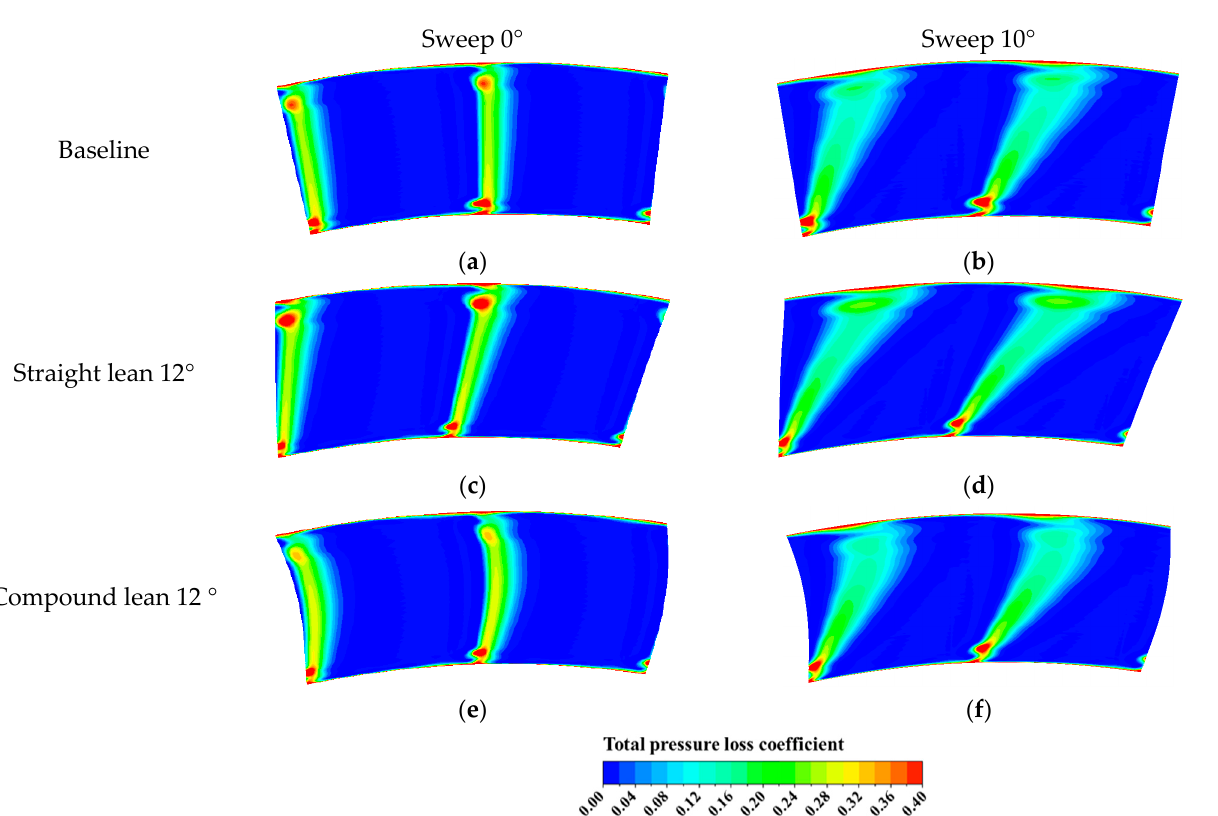
Figure 10. Distributions of total pressure loss coefficient at NGV exit, z/C ax = 1.06 (rear view): ( a ) SL0 SP0; ( b ) SL0 SP10; ( c ) SL12 SP0; ( d ) SL12 SP10; ( e ) CL12 SP0; ( f ) CL12 SP10.